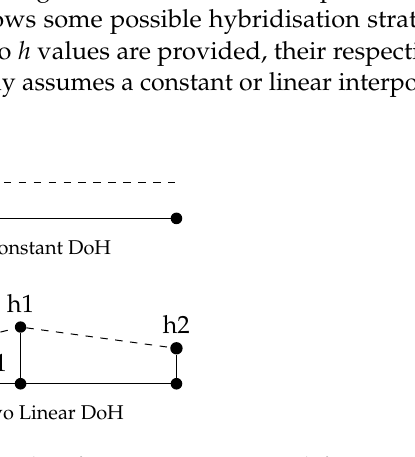
Figure 3. Examples of energy management definitions over a single mission